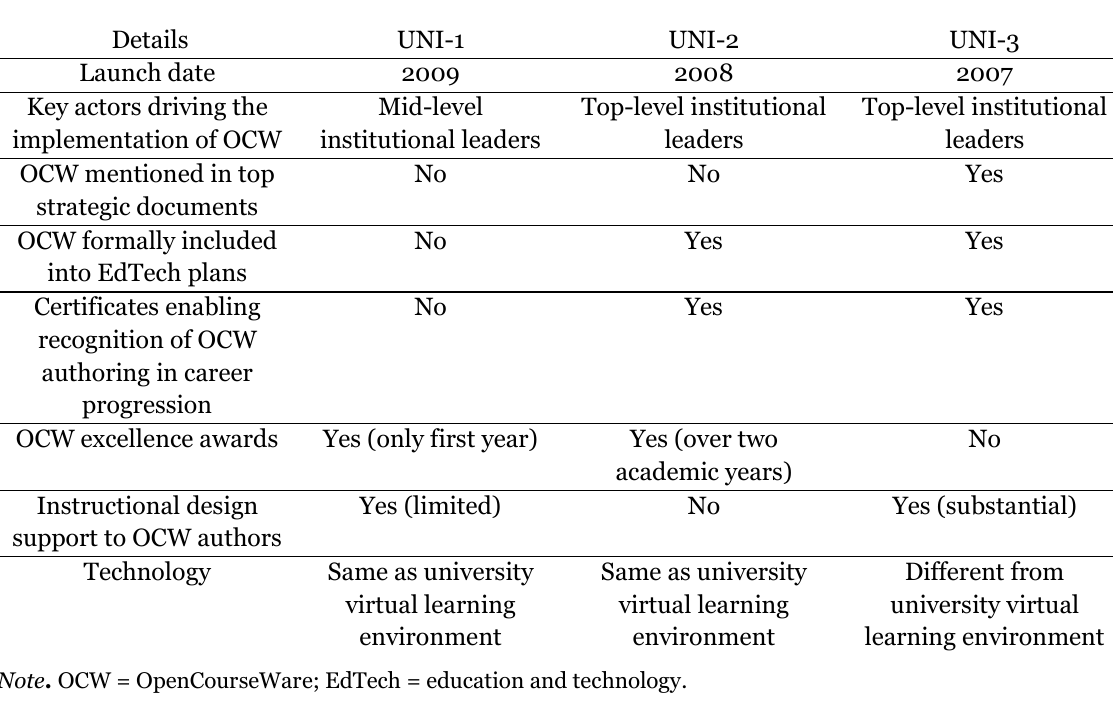
Table 2 Key Differences in OpenCourseWare